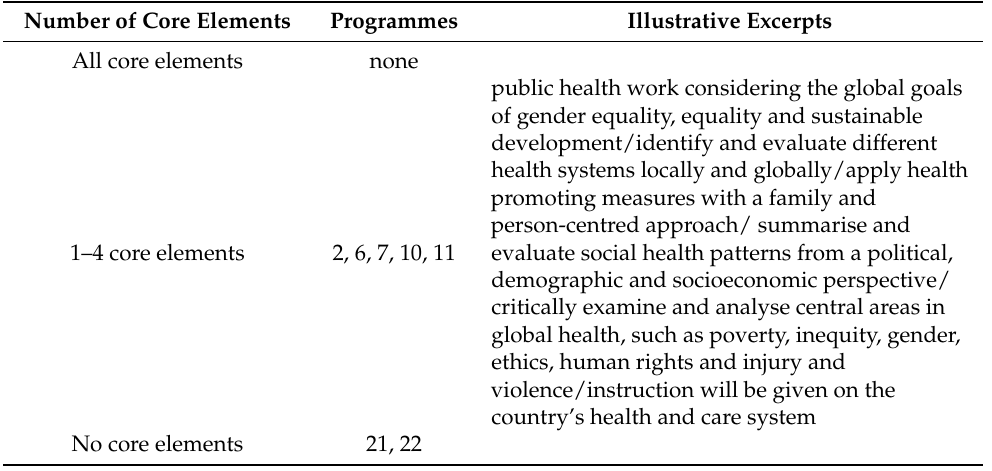
Table 3. Syllabi grouped under the theme International